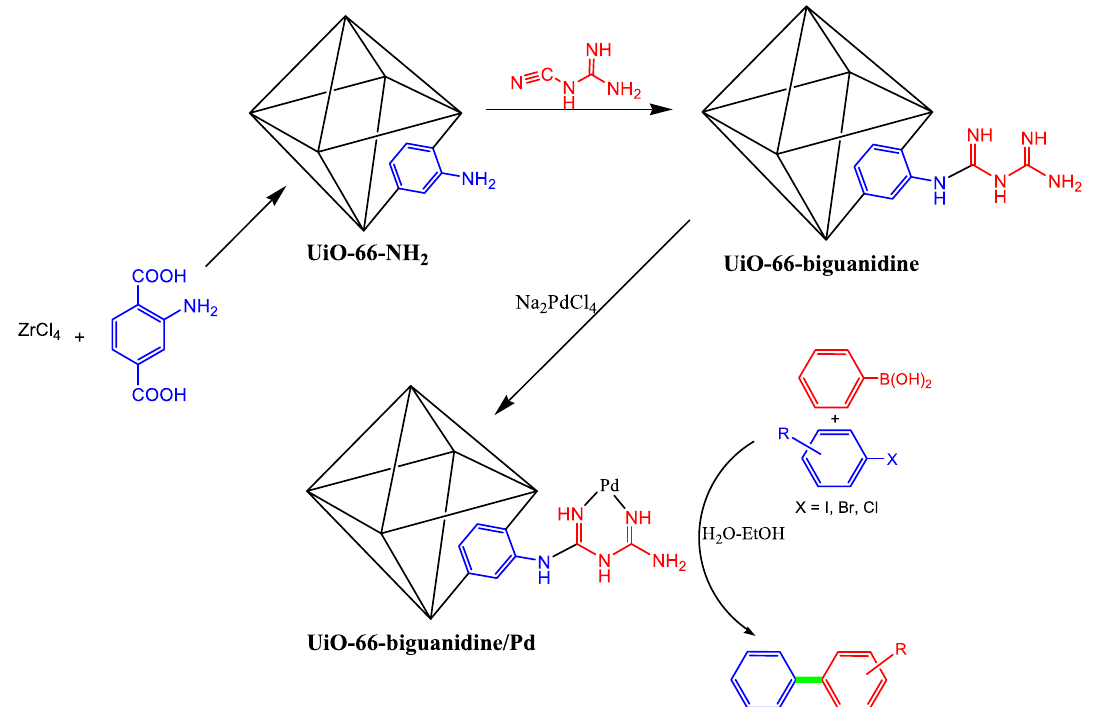
Figure 1. Sequential synthesis of UiO-66-biguanidine/Pd nanocomposite catalyst towards the Suzuki–Miyaura coupling